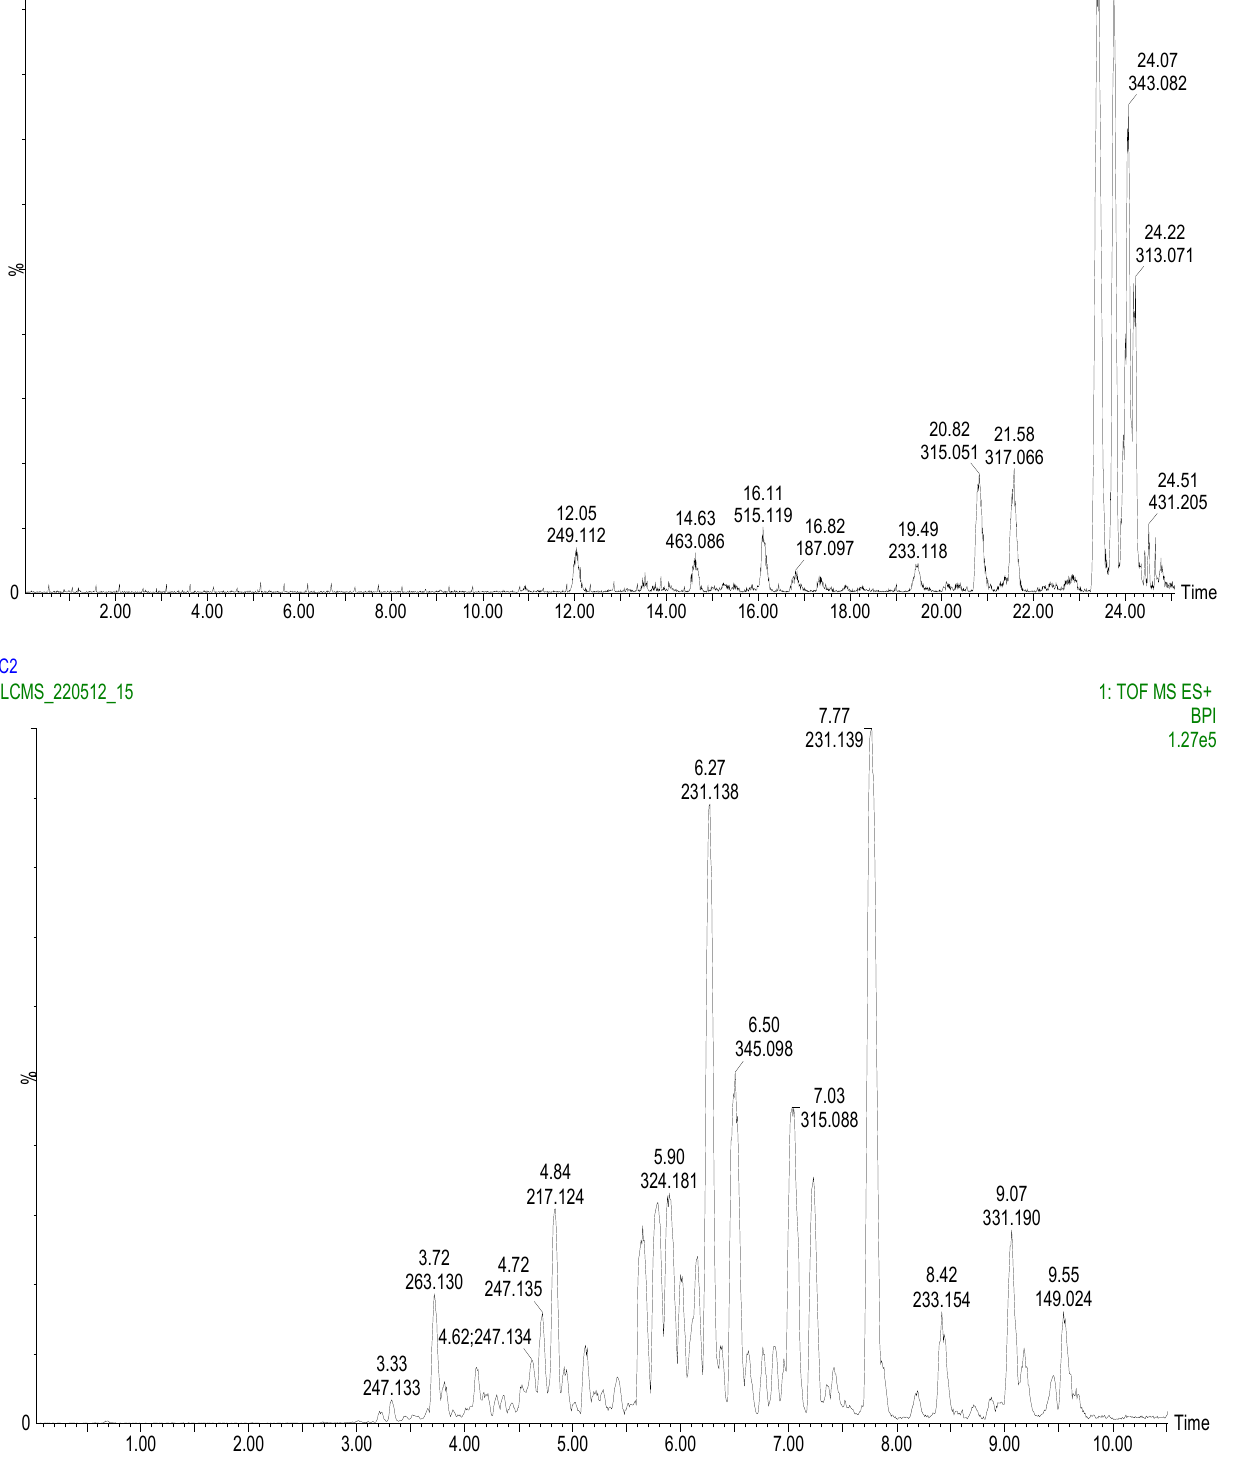
Figure 1. UHPLC-ESI-MS base peak chromatogram for the methanol extract of E. africanus ’s nega- tive and positive ion modes.